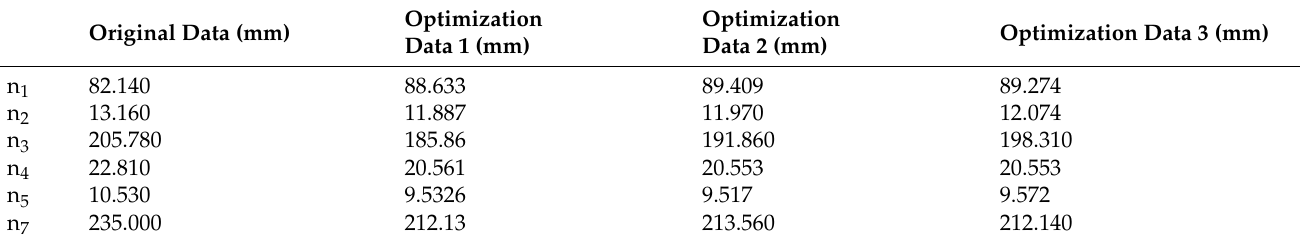
Table 11. Size parameters after and before optimization.